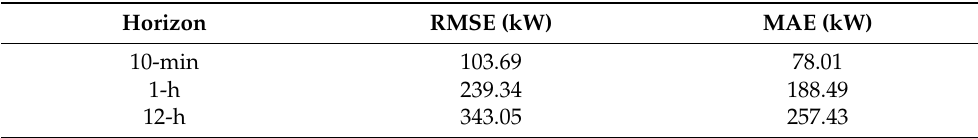
Table 14. Summary of the adjusted models for the three horizons.